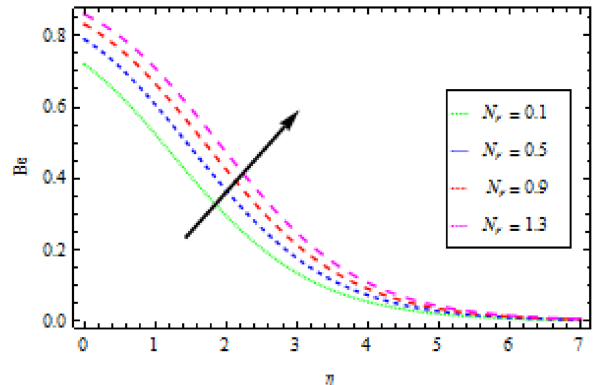
Figure 19. Effects of N r on Bejan number.